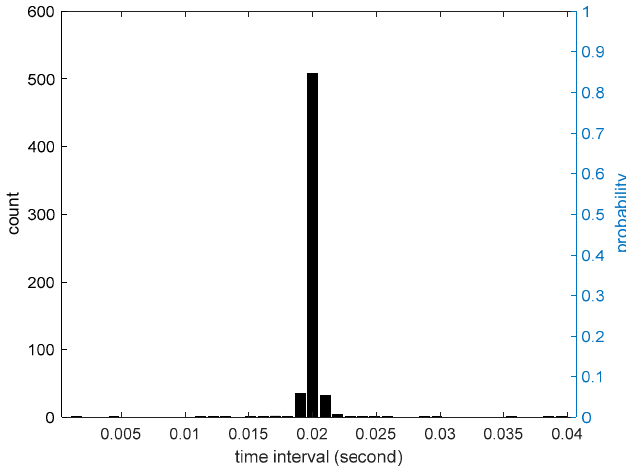
Figure 10. The distribution of time interval of response data collected by smartphones.